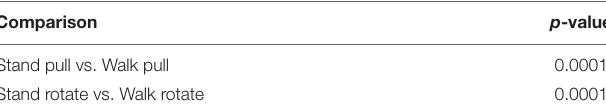
TABLE 4 | Comparison of the sample entropy of EMG signals between walking and standing in case of pulling and rotating. Comparison p -value Stand pull vs. Walk pull 0.0001 Stand rotate vs. Walk rotate